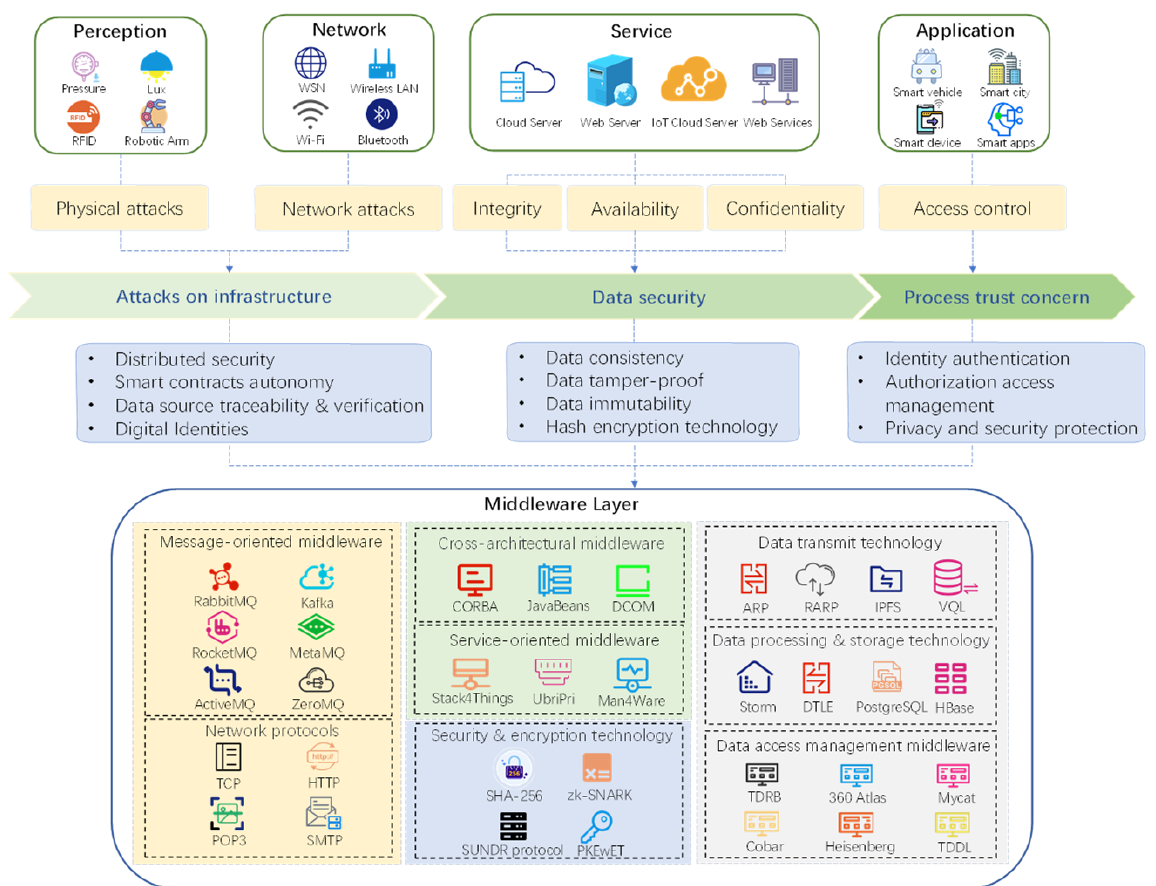
Figure 1. Conventional middleware solution and security issues for IIoT.